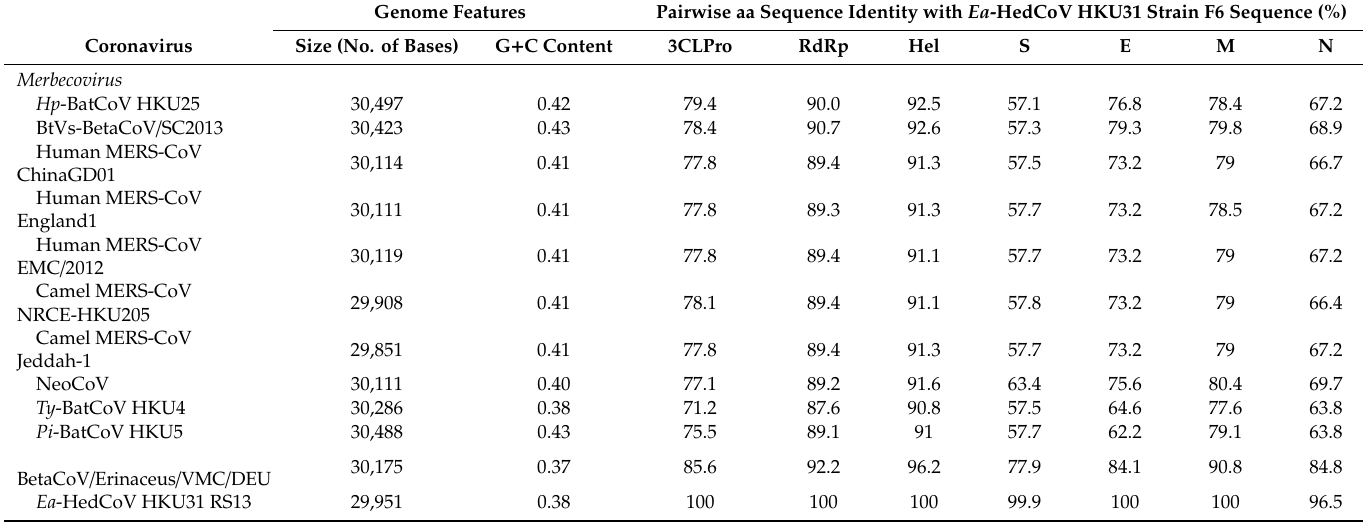
Table 1. Genomic features of Ea -HedCoV HKU31 and other members of Merbecovirus which complete genome sequences are available and amino acid identities between the predicted proteins of Ea -HedCoV HKU31 and the corresponding proteins of other members of Merbecovirus